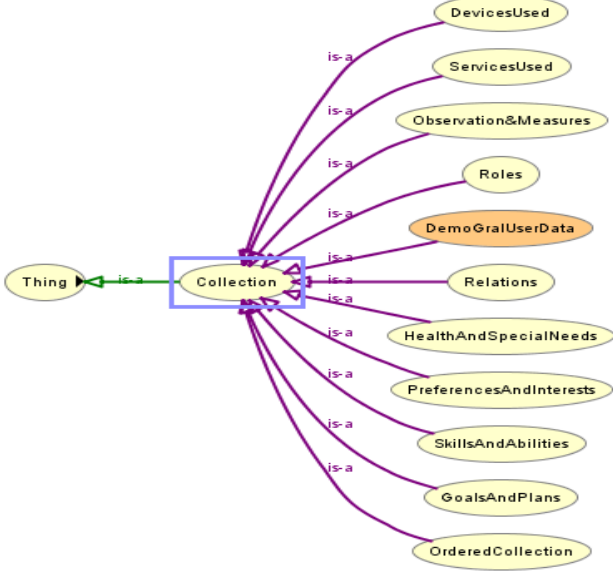
Figure 1. Ubiquitous user model